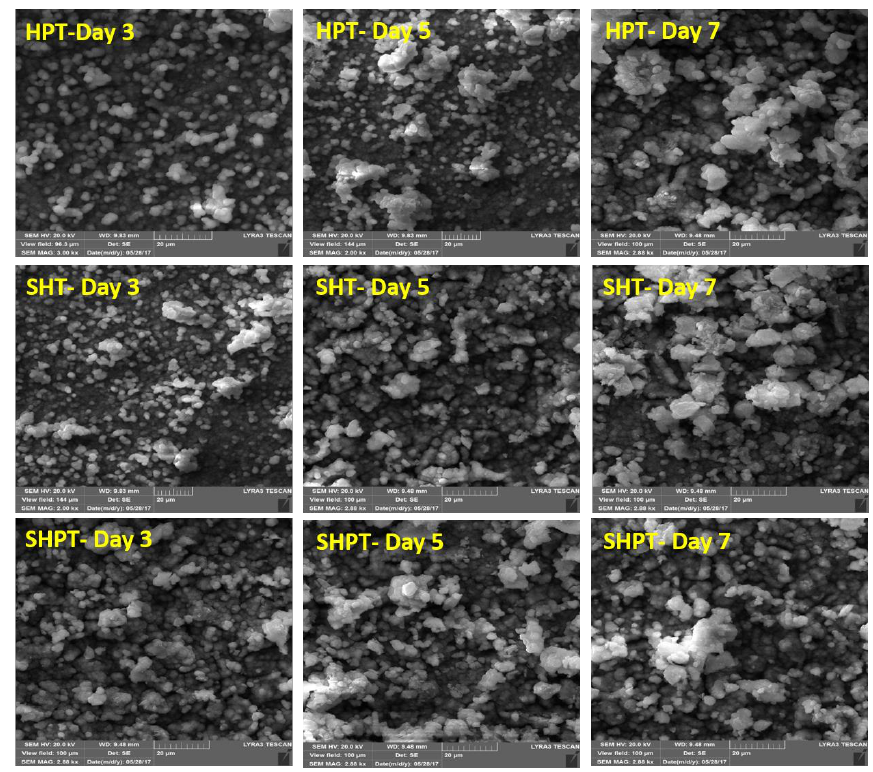
Figure 8. SEM images of treated specimens after immersion in SBF medium.